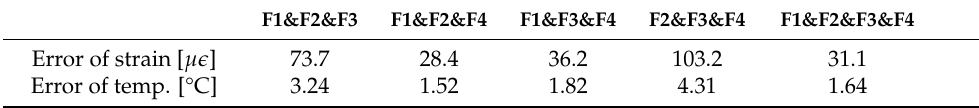
Table 3. Evaluated error of simultaneous measurement when combining three or four types of